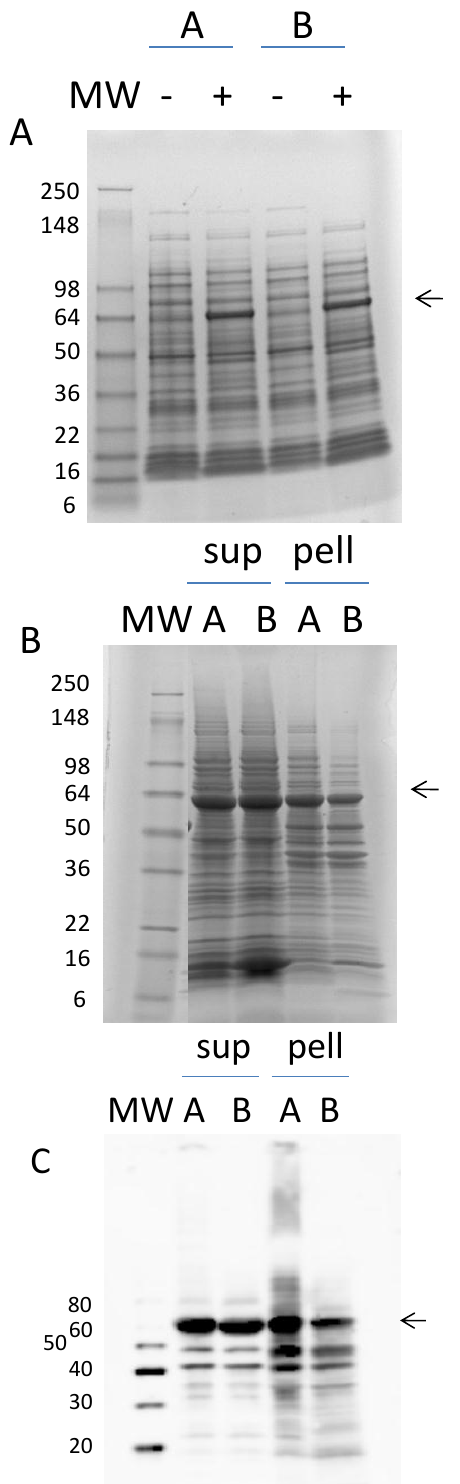
Figure 2. ( A ) SDS-PAGE of induced (+) and non-induced (−) cultures for clones A and B. The position of the induced mature rAra h 1 is indicated with an arrow. ( B ) SDS-PAGE of the soluble and insoluble fractions of induced cells (A and B clones) following lysis. “sup” is the soluble supernatant. “pell” is the insoluble cellular debris. ( C ) Western blot analysis with anti-Ara h 1 antibody of the same samples shown in